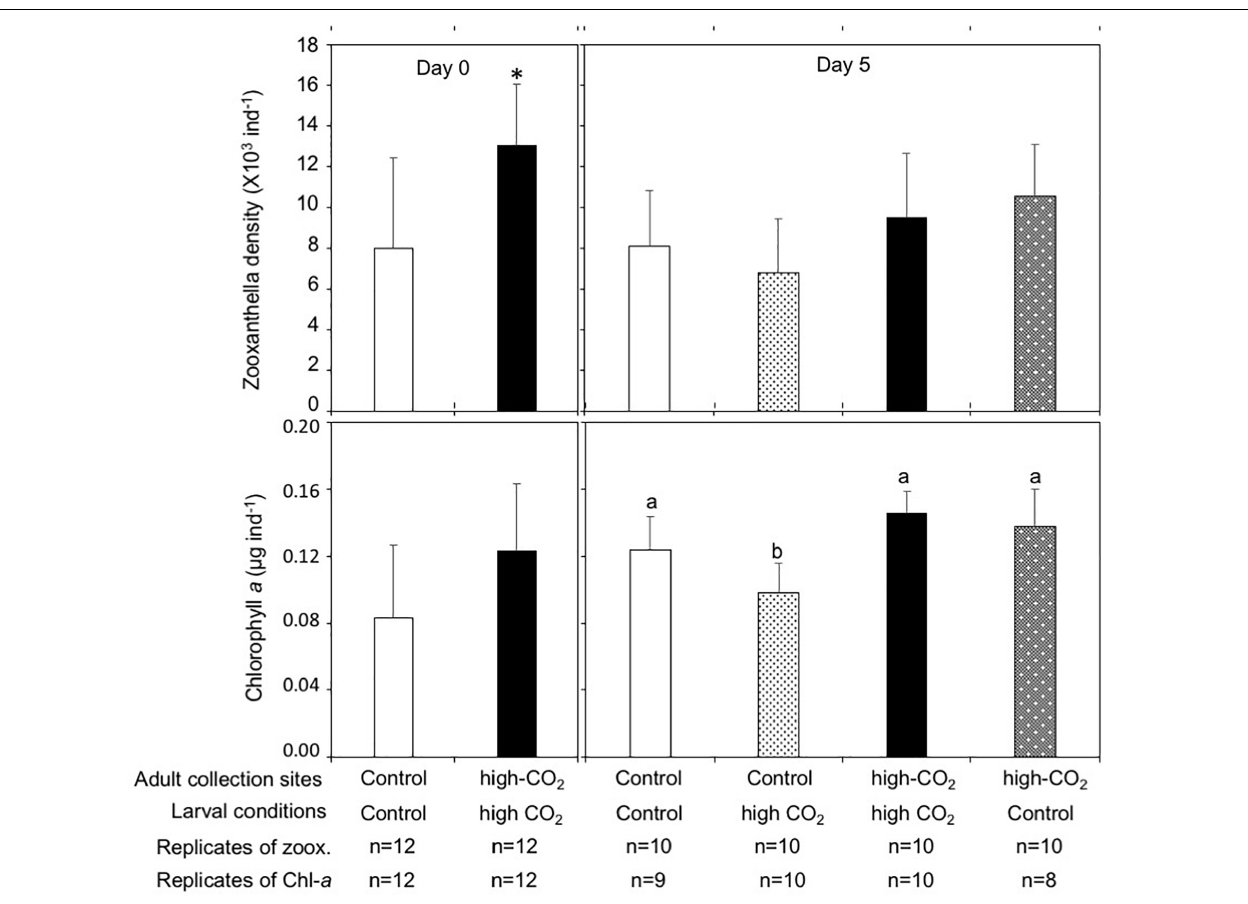
FIGURE 2 | Zooxanthella density and Chl- a concentrations in Pocillopora acuta larvae released from adults collected at control (white bar) and high-CO 2 (black bar) sites at Day 0, and at Day 5 after being reciprocally reared under control or high CO 2 conditions. At Day 0 differences among larvae from control and high-CO 2 sites were compared by t -test and Wilcoxon-test, respectively. Asterisk shows significant differences among control and high CO 2 . At Day 5, both zooxanthella density [ F ( 1 , 36 ) = 9.31, p = 0.004] and Chl- a [ F ( 1 , 36 ) = 59.9, p < 0.001] of the larvae originating from high CO 2 adults were significantly higher compared to larvae originating from control adults. Additionally, Chl- a showed a significant interaction among the parent origin and the seawater condition that larvae were